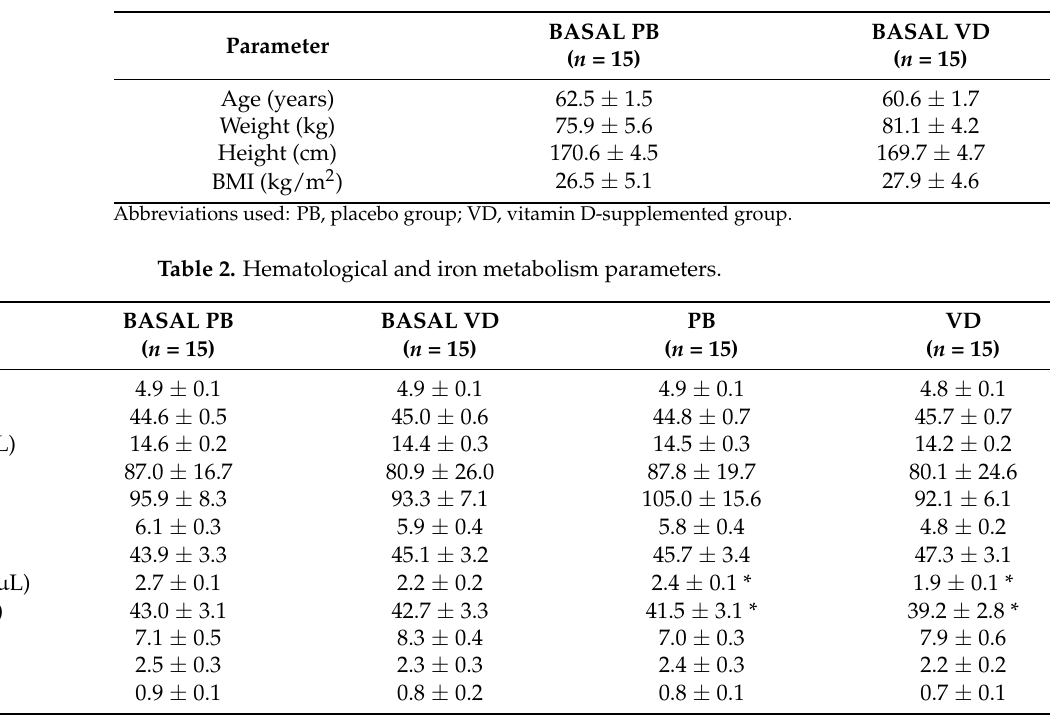
Table 1. Age and anthropometric characteristics of the studied participants.